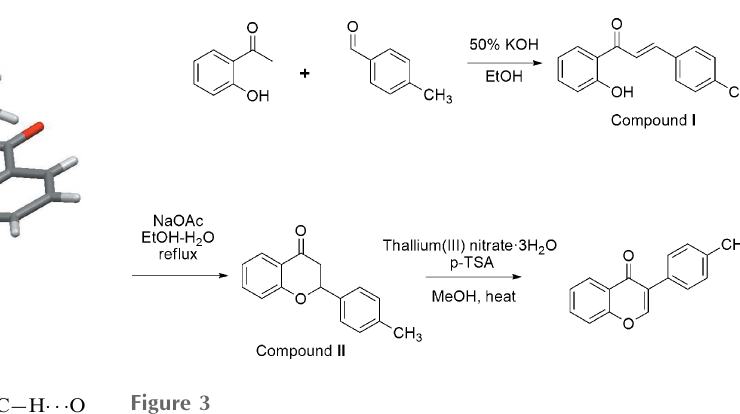
Figure 3 Synthetic scheme for the preparation of the title compound.